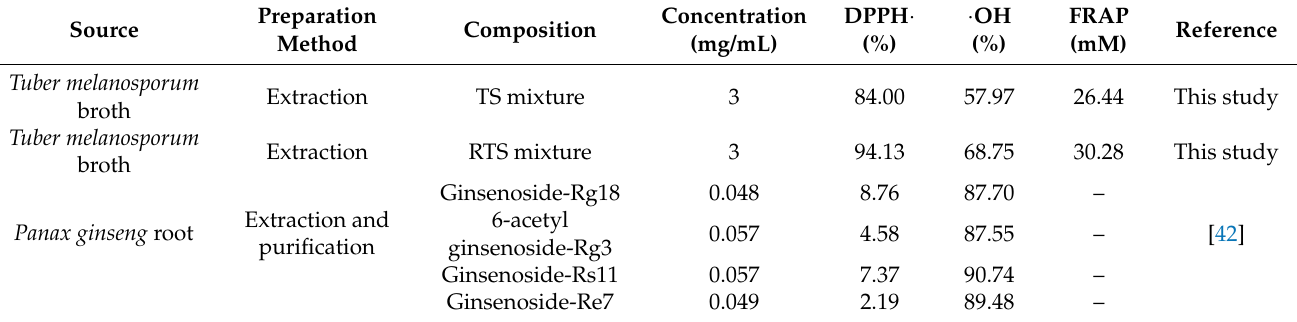
Table 7. Antioxidant activities of the different saponins from plants and